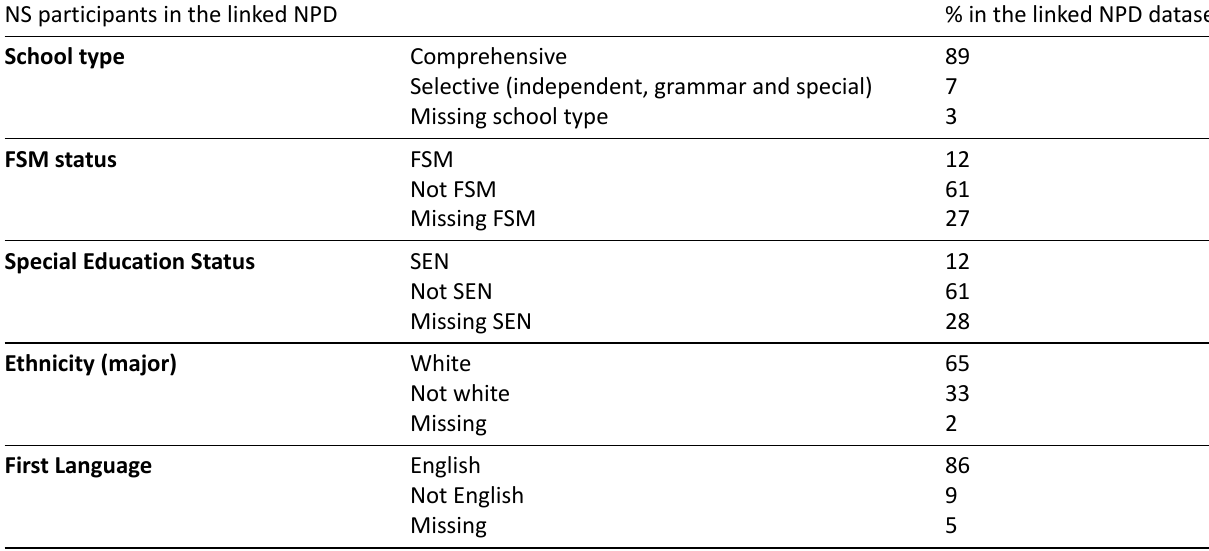
Table 3. Percentage of cases with complete and missing data for key variables in the linked dataset. NS participants in the linked